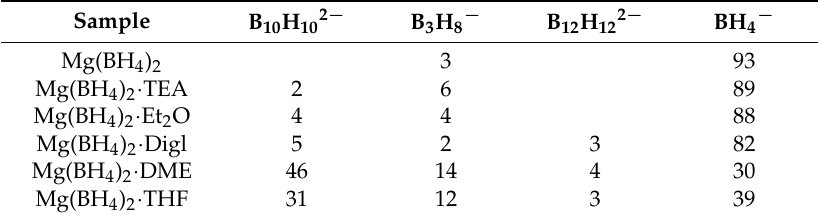
Table 2. Distribution of products of Mg(BH 4 ) 2 solvates determined from integration of 11 B NMR peaks in mol % after dehydrogenation at 180 ◦ C, 24 h, 1 atm N 2 . The balance of products consist of trace quantities of boric acid due to hydrolysis of unstable polyboranes.